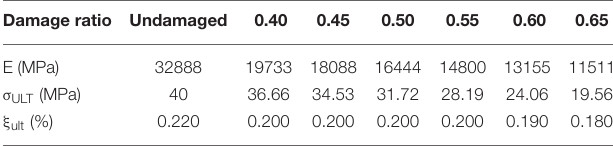
TABLE 1 | Undamaged and damaged concrete material